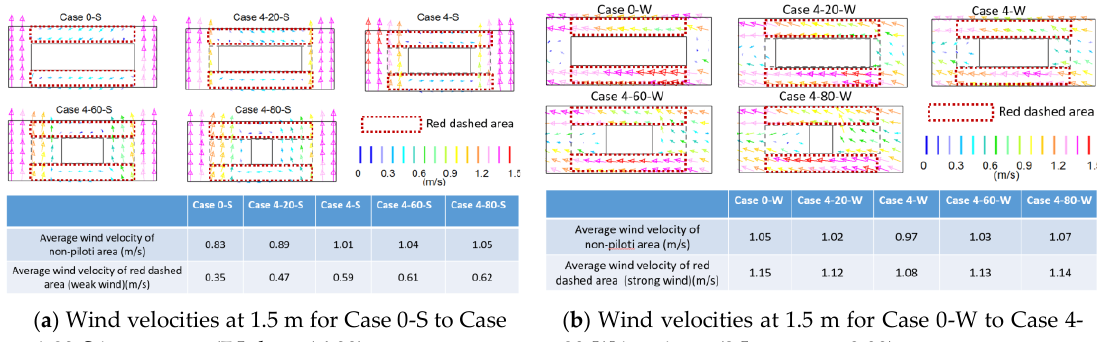
Figure 10. The wind velocity results for the piloti arrangements.